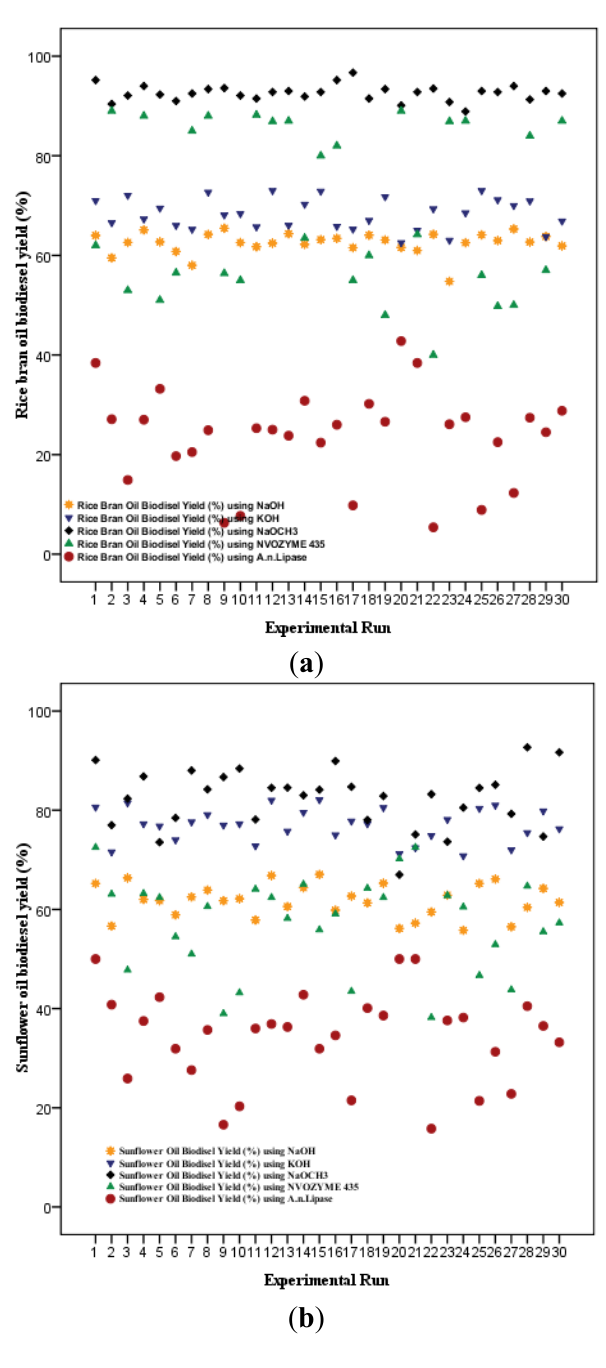
Figure 1. Comparative description of biodiesel yields (%) resulted from 30 experiments executed under reaction conditions defined by CCRD for chemical and enzymatic transesterification of ( a ) rice bran oil and ( b ) sunflower